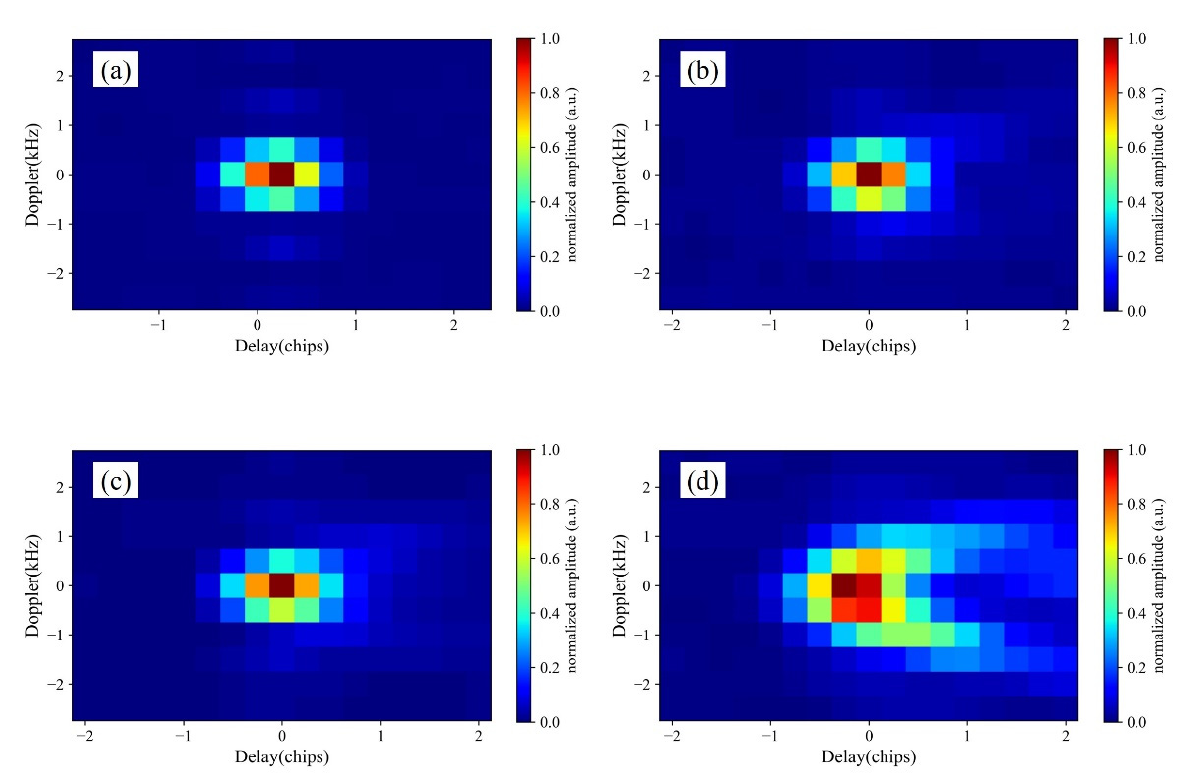
Figure 4. DDMs with specular reflection points falling on land ( a – c ) and water ( d ). Table 1. Information of the example DDMs.